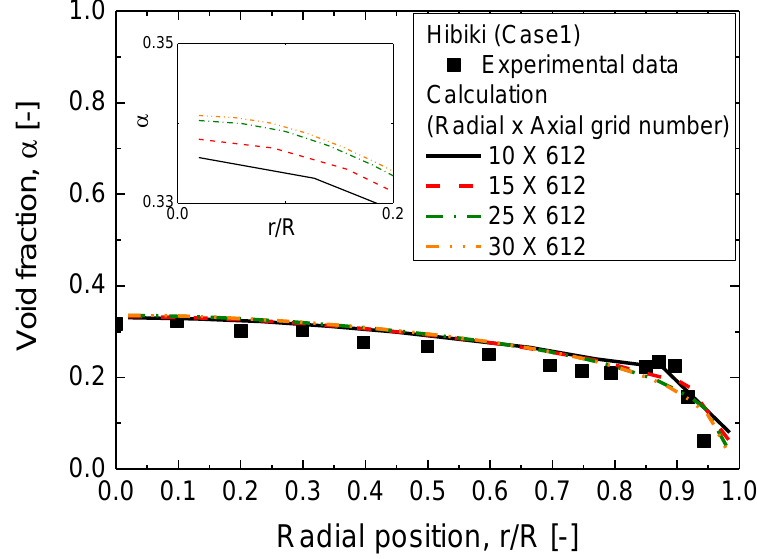
Figure 4. Results of grid sensitivity study for the Hibiki experiment. Table 5. Grids used in the benchmark calculation of each experiment.